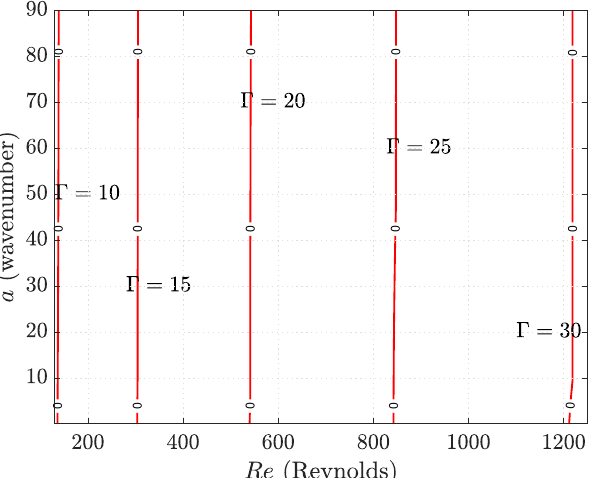
Figure 11. Neutral stability curves, the flow between rotating cylinders. Γ = 10,15,20,25,30.